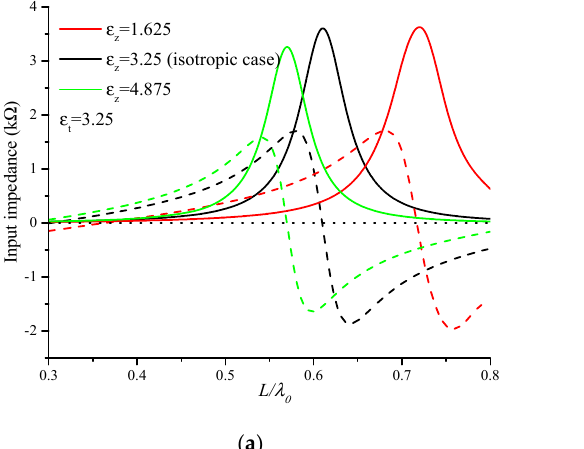
Figure 12. Real and imaginary parts of the input impedance for various values of ( a ): ε z and ( b ): ε t